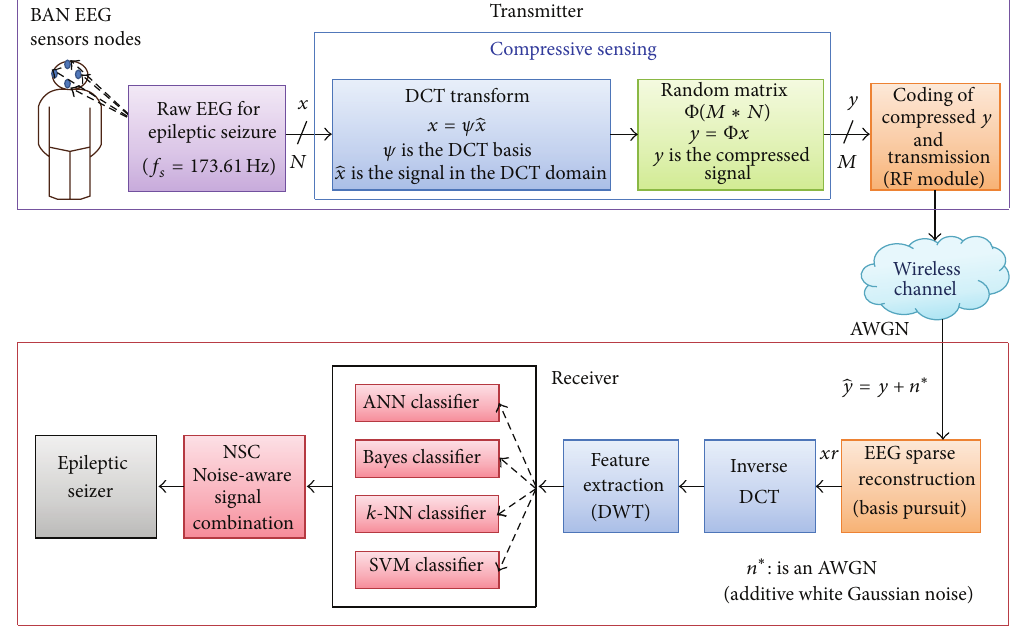
Figure 1: EEG-based epileptic seizure framework.